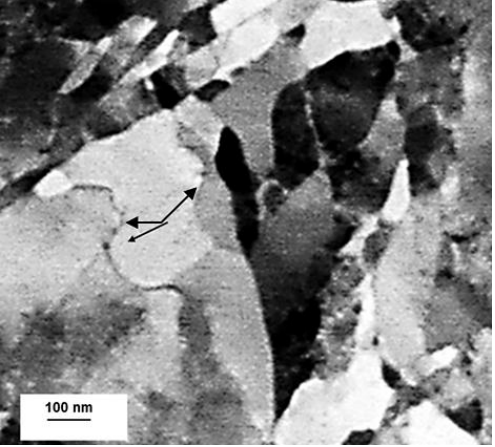
Figure 12. Thermal stability of swaged and ARB-processed CuNi3Si1Mg as compared to conventional strip.